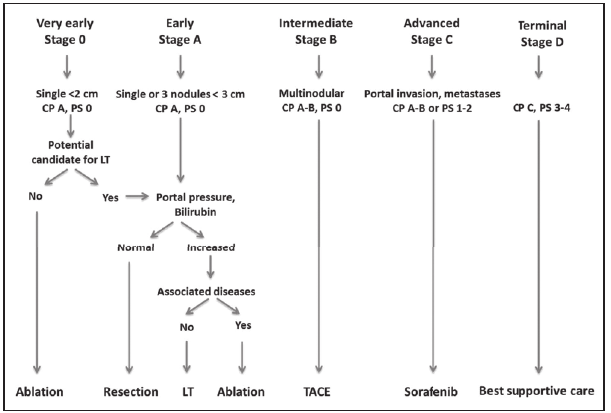
Figure 3) Barcelona Clinic Liver Cancer stages and allocation of treat- ment. CP Child-Pugh class; LT Liver transplantation; PS Eastern Cooperative Oncology Group performance status; TACE